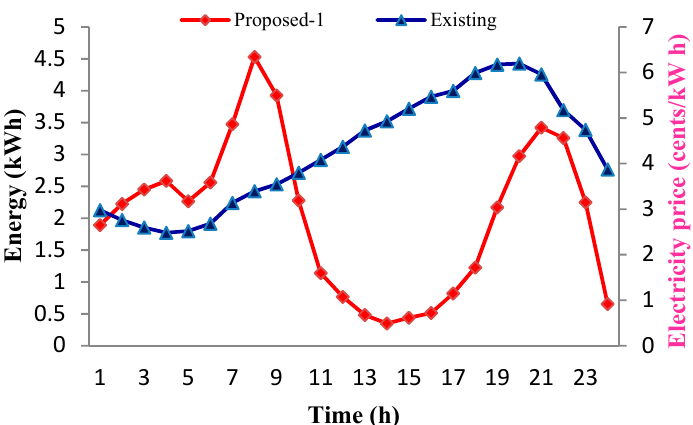
Figure 10. Comparison between proposed-1 and existing scenario of energy and electricity cost management over 24 h time horizon.